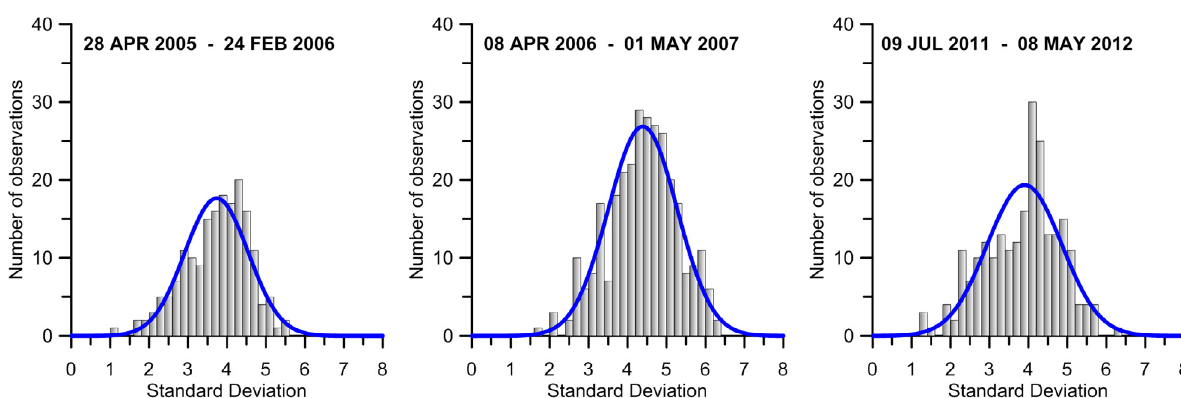
Figure 7. Standard deviation of the scene for the three different IR image time series.